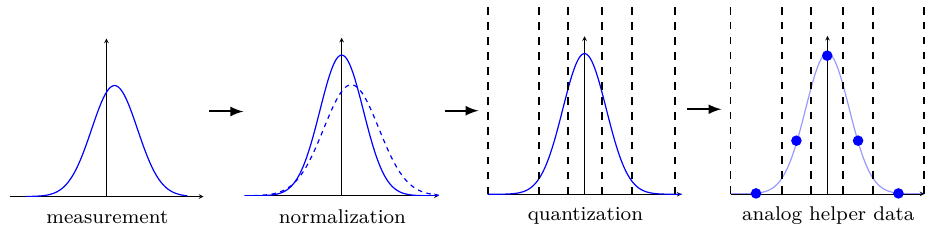
Figure 3: Post-processing of the PUF-response after measurement and helper data gener-